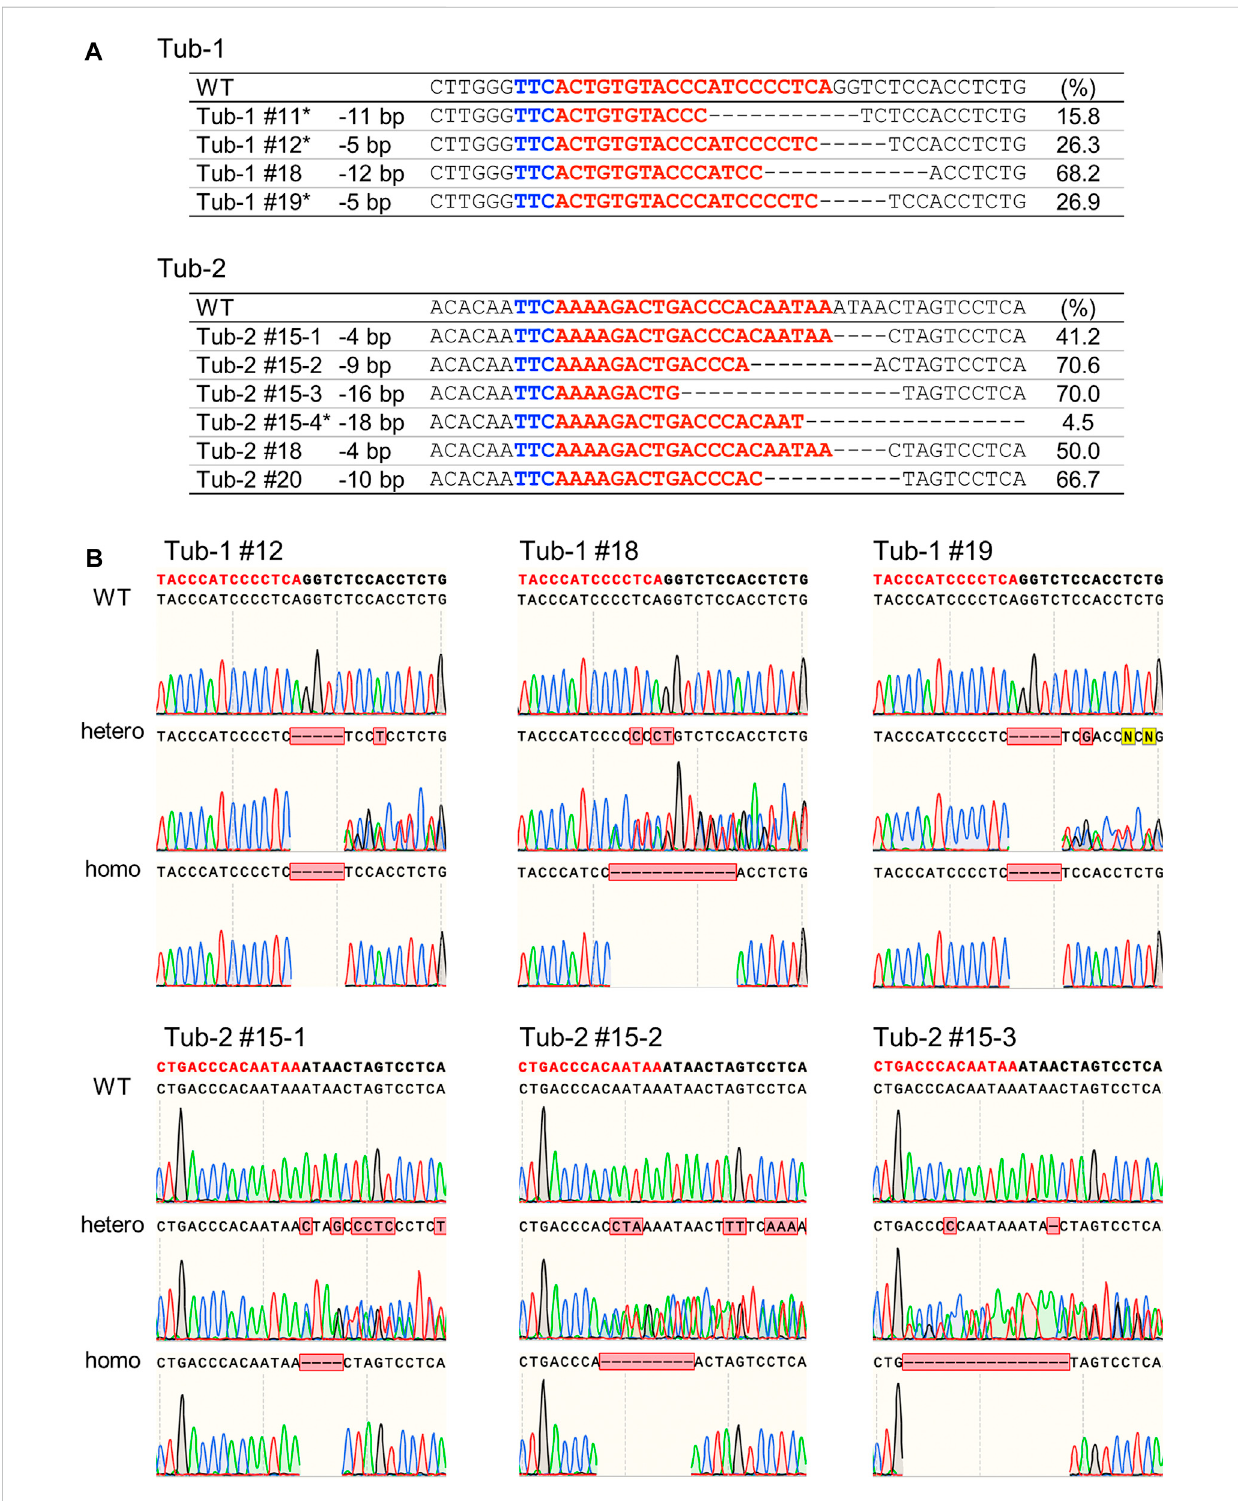
FIGURE 4 Analysis of SpCas12f-induced mutations in regenerated plants and their progenies in rice. (A) Sanger sequencing results on Tub-1 (upper panel) and Tub-2 (lowerpanel)inregeneratedplants ofTub-1(#11,#12,#18,#19,upperpanel)andTub-2 (#15,#18,#20,lowerpanel).DetailsasinFigure2B.*The mutant: WT ratio did not fi t to 1:1 by χ 2 -test. (B) Sequencing chromatograms at the Tub-1 and Tub-2 sites in T 1 plants of Tub-1#12, Tub-1#18, Tub-1#19, Tub-2#15 – 1, Tub-2#15 – 2, and Tub-2#15 – 3. PCR fragments were sequenced